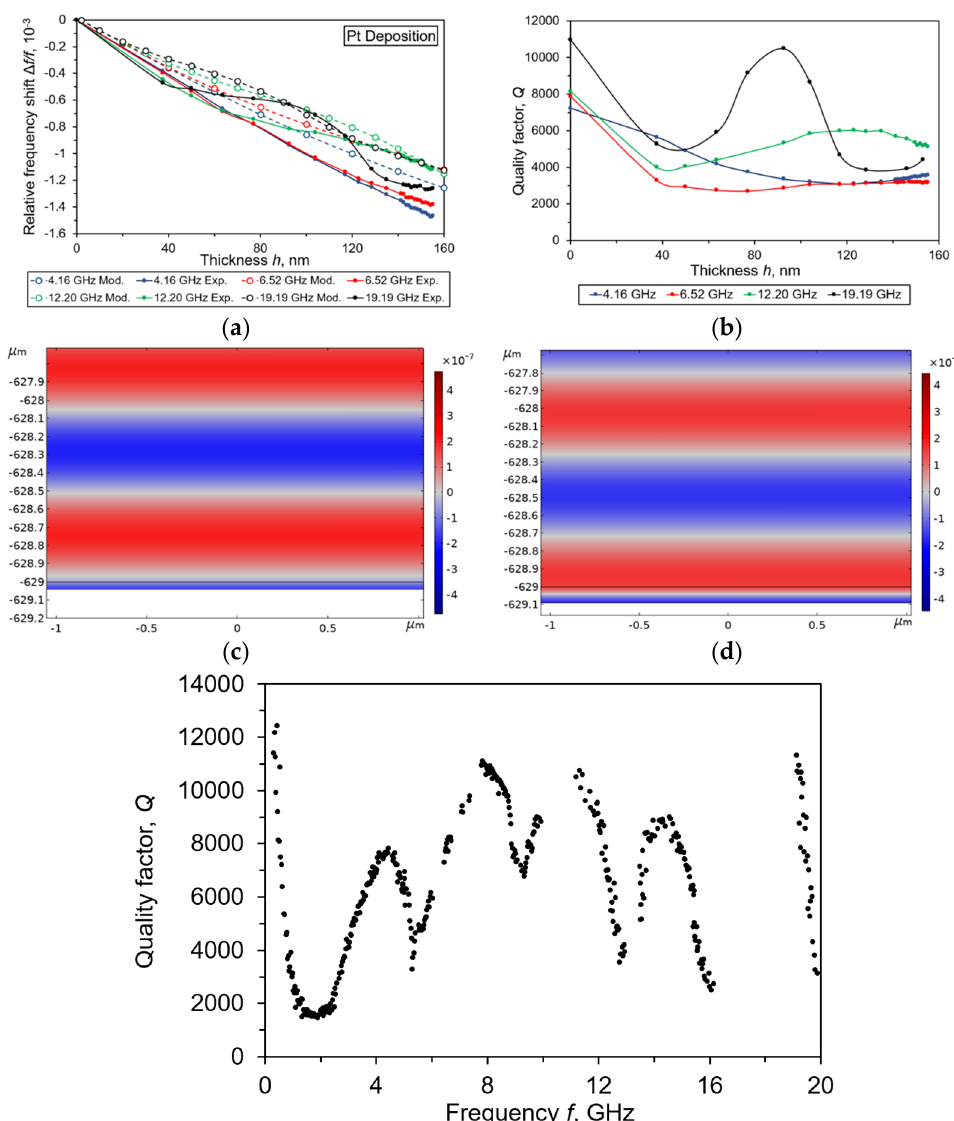
Figure 5. Relative frequency shift ( a ) and quality factor ( b ) vs. the Pt film thickness measured for the microwave acoustic overtones taken at four operational frequencies of sensor #C. Model distribution of the L-BAW vertical Y-component of elastic displacements when h = 45 nm ( c ) and 90 nm ( d ) at 19.19 GHz. ( e ) Preliminary measurement of the Q-factor frequency dependence.